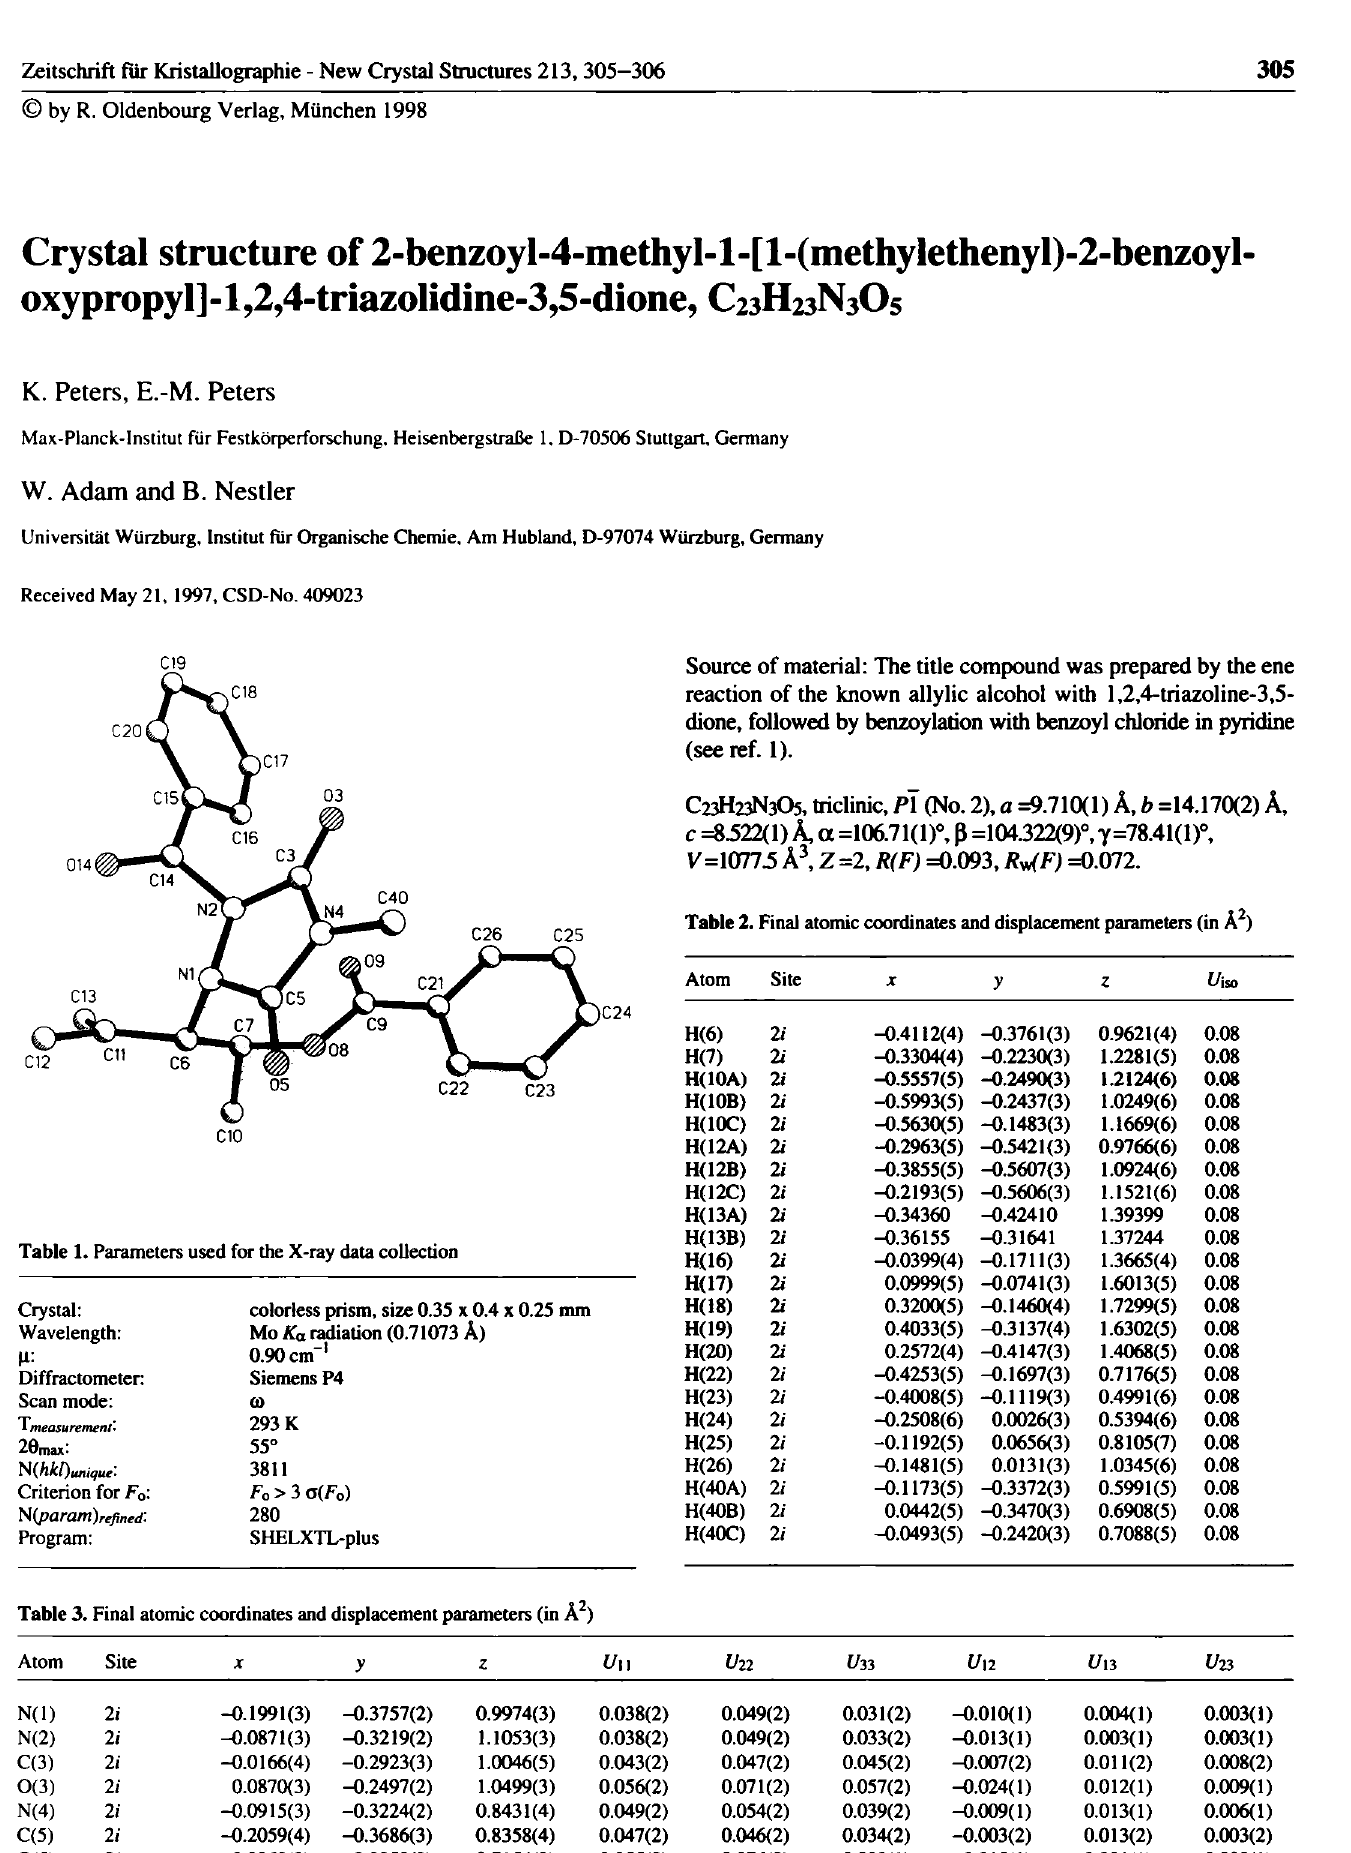
Table 3. Final atomic coordinates and displacement parameters (in Â^)